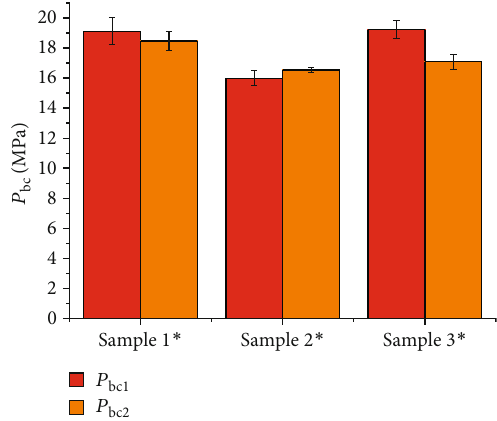
Figure 5: (1) Compressive-strength test 1. Columns in red color for samples containing only FLA A additive ( P bc1 ); columns in orange color for samples containing FLA A and 0.75%BWOC dispersant SXY-2 ( P bc2 ). Sample 1 ∗ : 1%BWOC FLA A; sample 2 ∗ : 2%BWOC FLA A; sample 3 ∗ : 3%BWOC FLA A. Note: P bc1 and P bc2 represent compressive strength of cement-based material